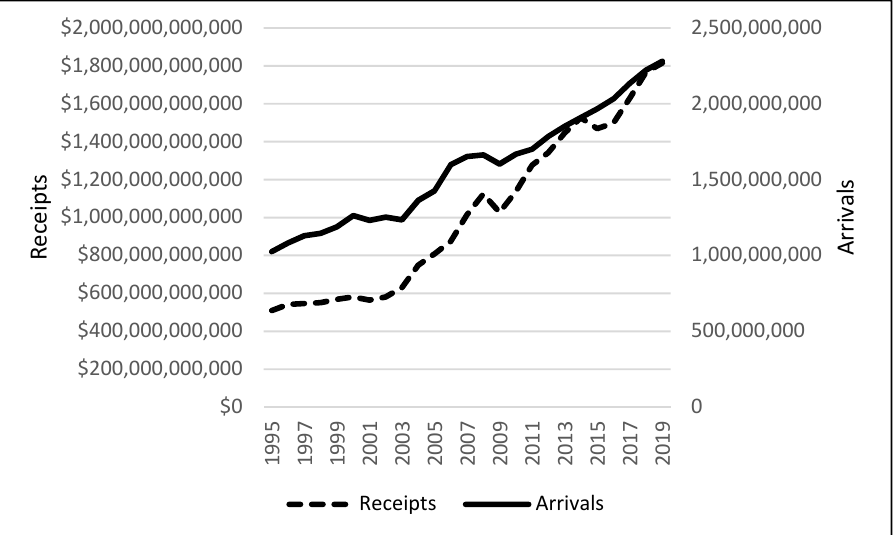
Figure 1. Total international tourist arrivals and tourism receipts. Source: United Nations World Tourism Organization, Yearbook of Tourism Statistics.